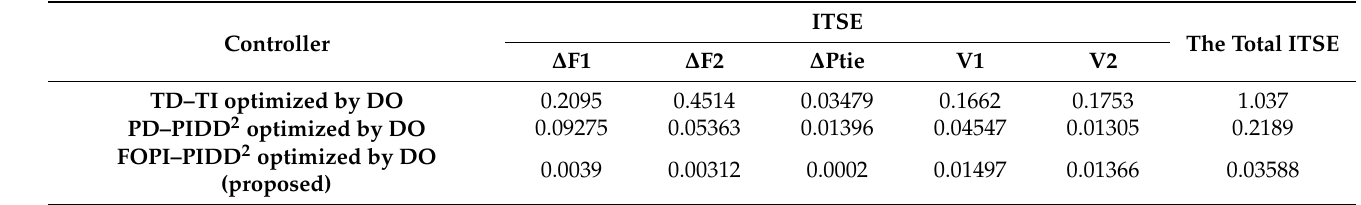
Table 5. Dynamic specifications of the investigated system represented as ITSE value using different controllers under scenario 3 impact.